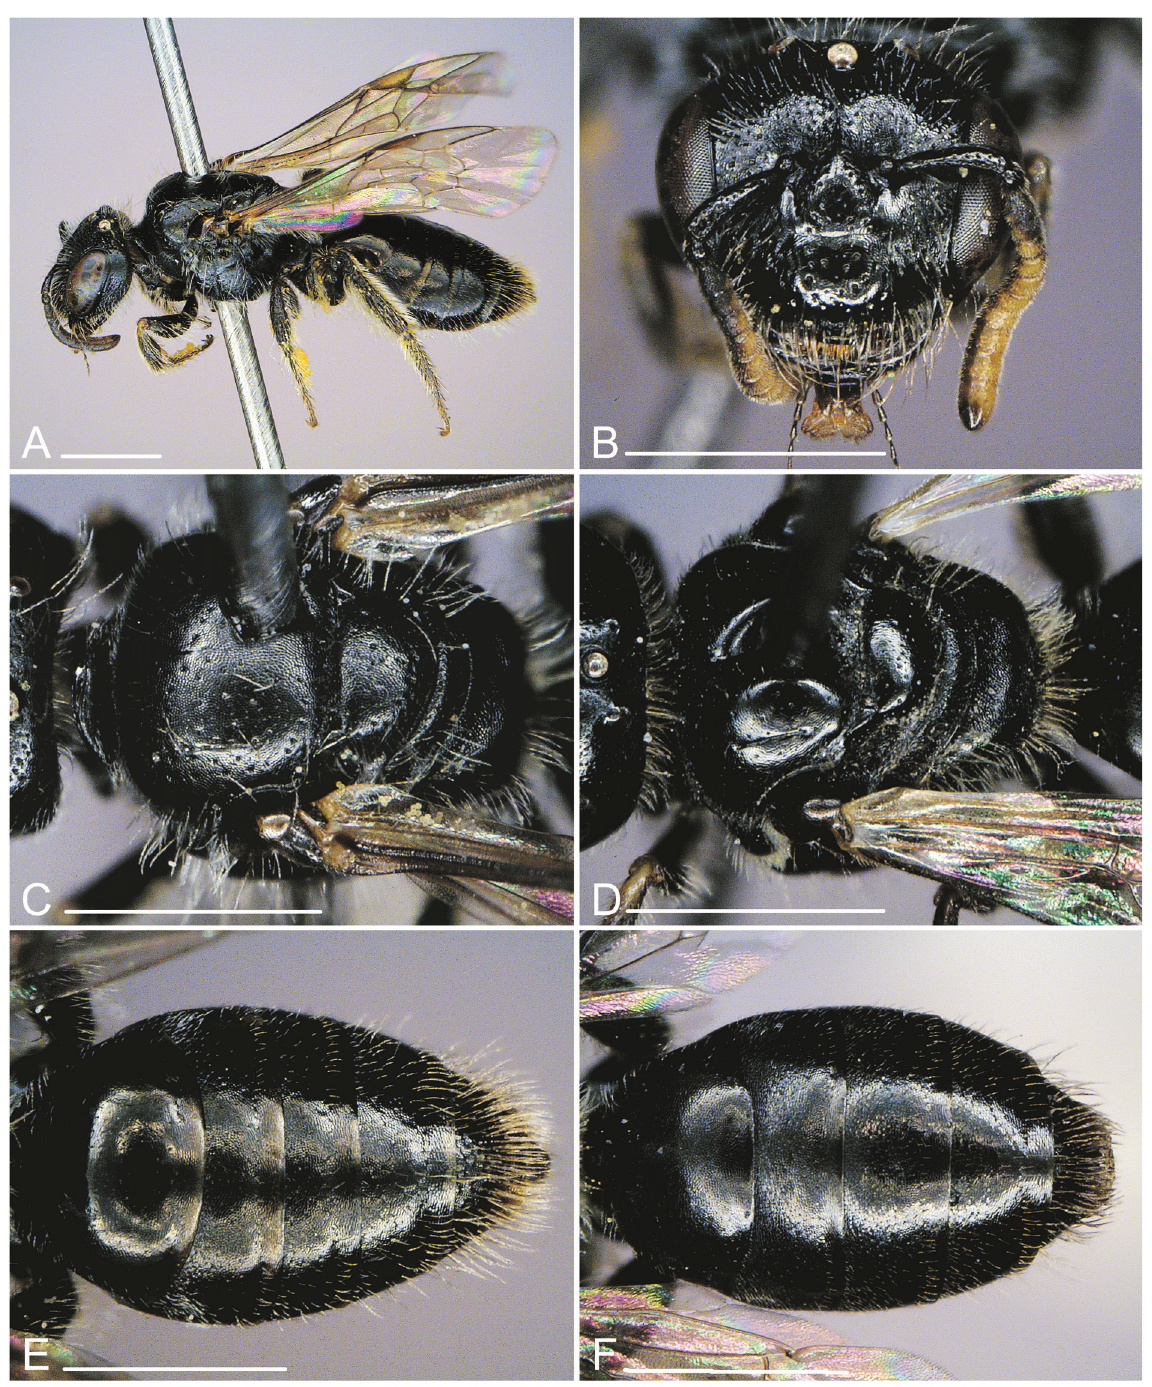
Fig. 3. Scrapter albitarsis (Friese, 1909), ♀. A . Lateral view. B . Head. C . Thorax (dorsal view). D . Thorax (dorsal view). E . Metasoma (dorsal view). F . Metasoma (dorsal view). Scale bars: